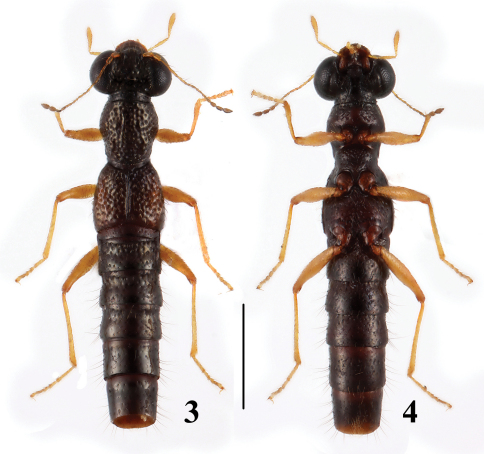
 Habitus ofStenus huanghaoi in dorsal and ventral view. Scale = 1 mm.